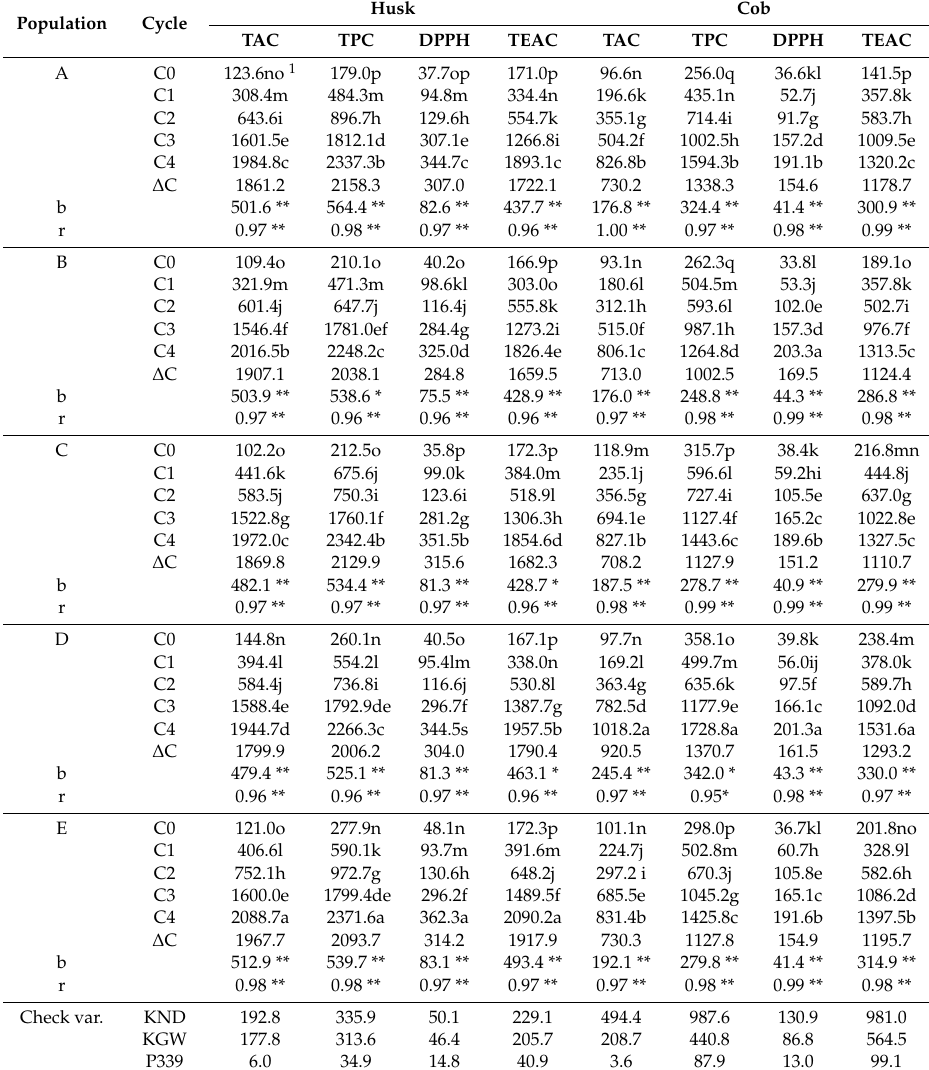
Table 6. Means for total anthocyanin content (TAC), total phenolic content (TPC) and antioxidant activity determined by the DPPH and the TEAC methods of (A–E) five populations and (C0–C4) five cycles evaluated across four